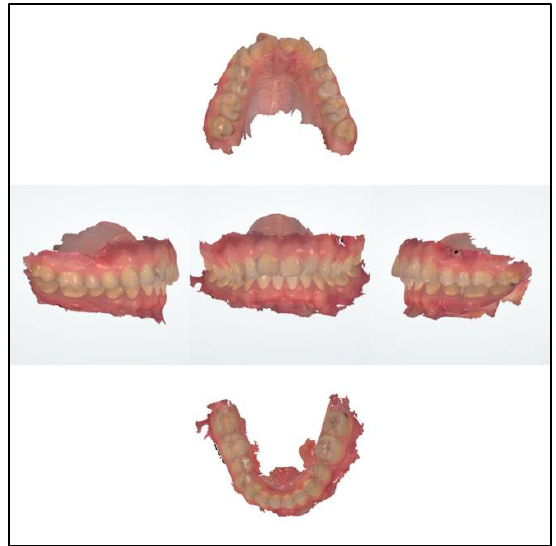
Figure 3. Virtual dental impressions.